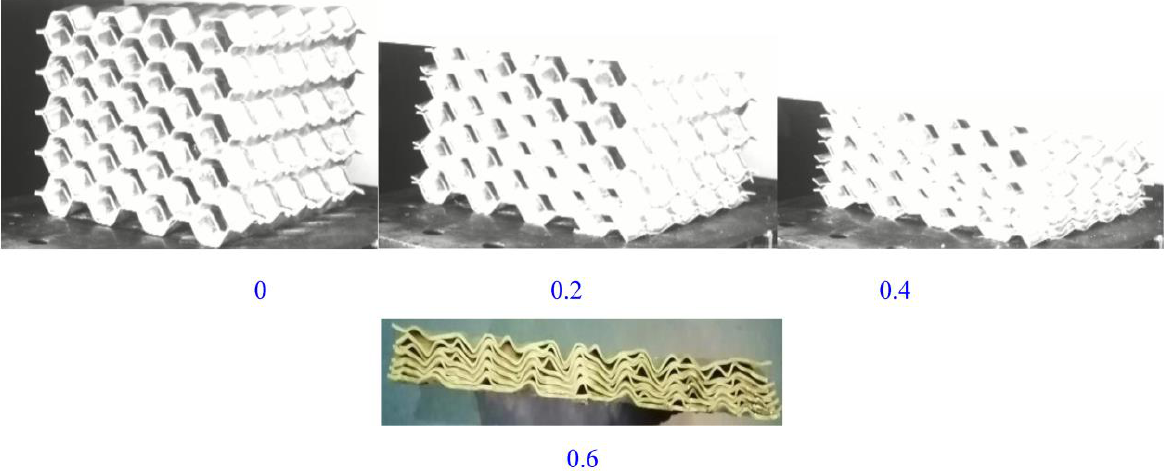
Figure 12. Dynamic test process in the lateral direction.